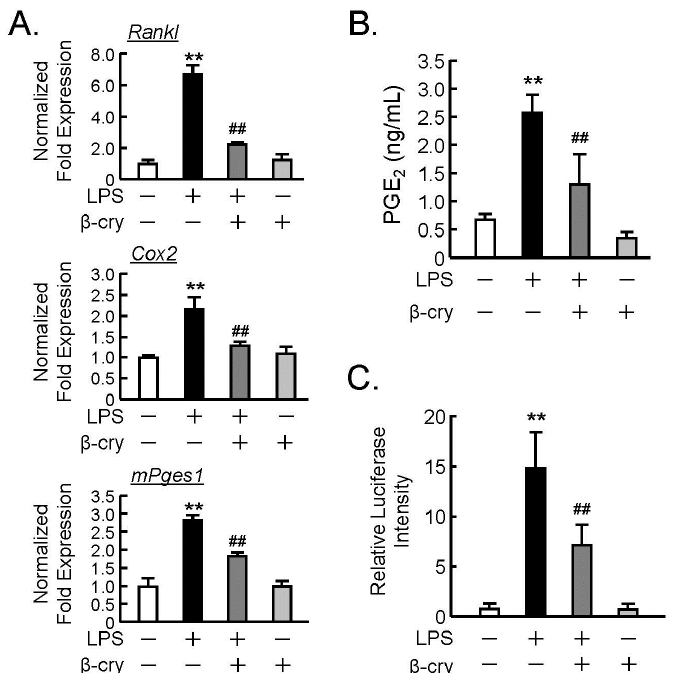
Figure 2. The effects of β -cry on the LPS-induced expression of cyclooxygenase (COX)-2, membrane-bound PGE synthase (mPGES)-1, and receptor activator of NF- κ B ligand (RANKL) mRNA on the production of prostaglandin (PG)E 2 in osteoblasts. Primary osteoblastic cells (POBs) were pre-treated with β -cry (5 µ M) for 24 h and further cultured for 24 h in the presence of LPS (1 µ g/mL) and β -cry (5 µ M). ( A ) The mRNA expression of RANKL, COX-2, and mPGES1 was analyzed by RT-qPCR. Data are expressed as the mean ± SD of three replicated wells in triplicate. ( B ) The PGE 2 concentration was measured in the cultured medium of POBs. ( C ) The transcription activity of NF- κ B was measured with or without β -cry (5 µ M). Plasmid pNFkB-TA-Luc (0.4 µ g) and the pGL4.74[hLuc/TK] plasmid (40 ng) were transfected into POBs, and the luciferase activity was measured with the Dual-Luciferase Reporter Assay System. Data are expressed as the mean ± SD for 3–4 independent wells. Significant differences are indicated, ** p < 0.01 vs. control; ## p < 0.01 vs.